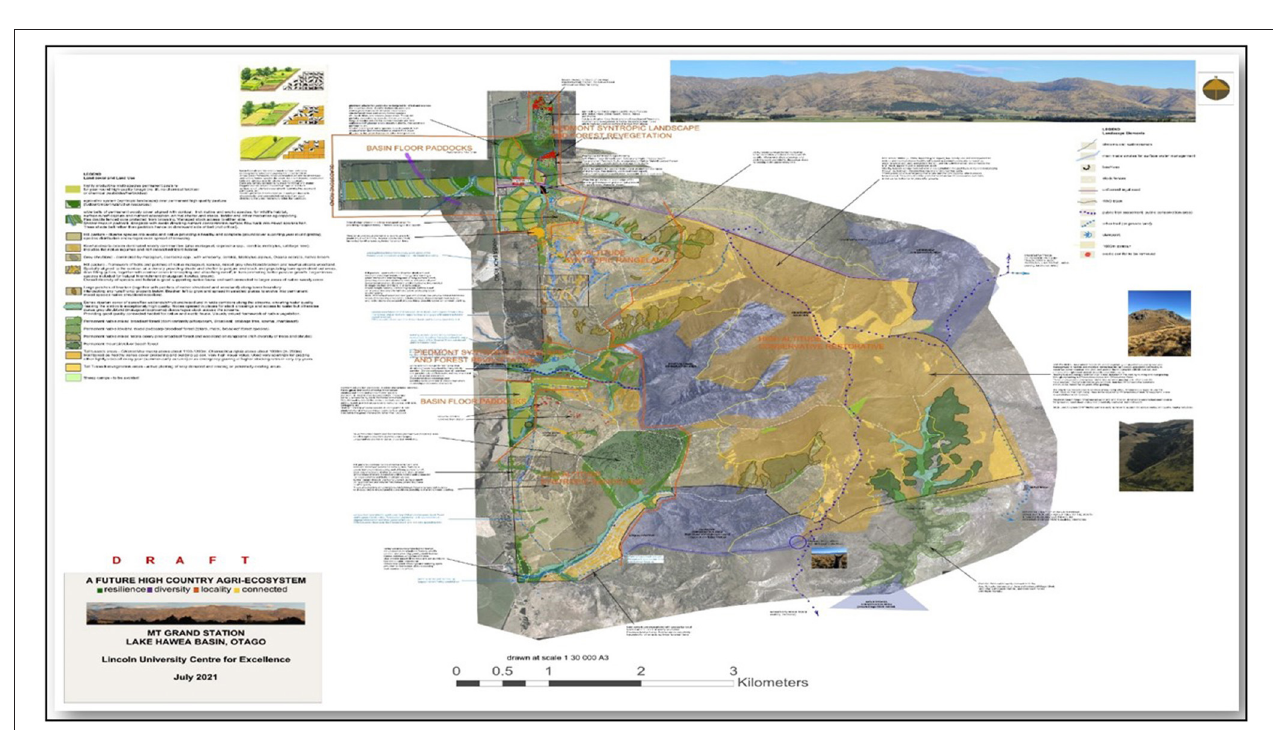
FIGURE 10 | Mt. Grand re-design